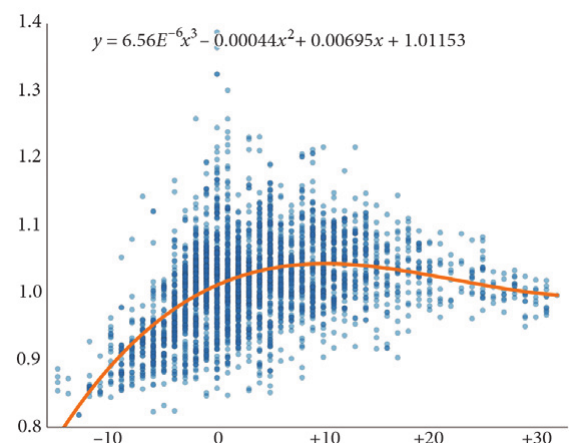
Fig. 2. Adjustment coefficients and describing function for A3 data